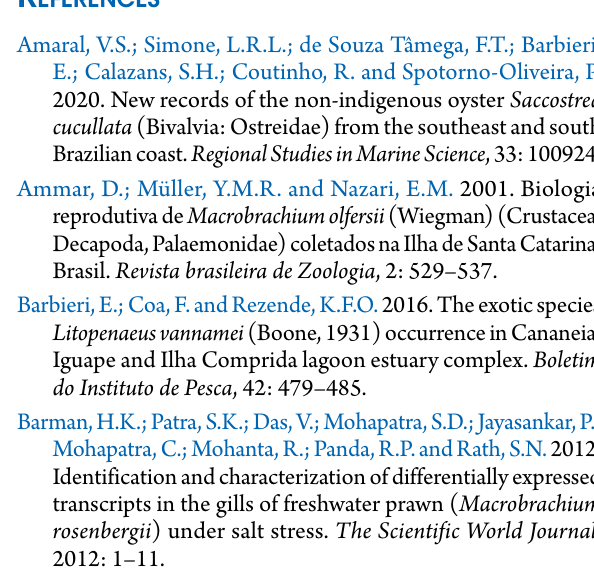
Table S1. Record of Macrobrachium rosenbergii in Brazil by classification and location. States: AL - Alagoas; BA - Bahia;